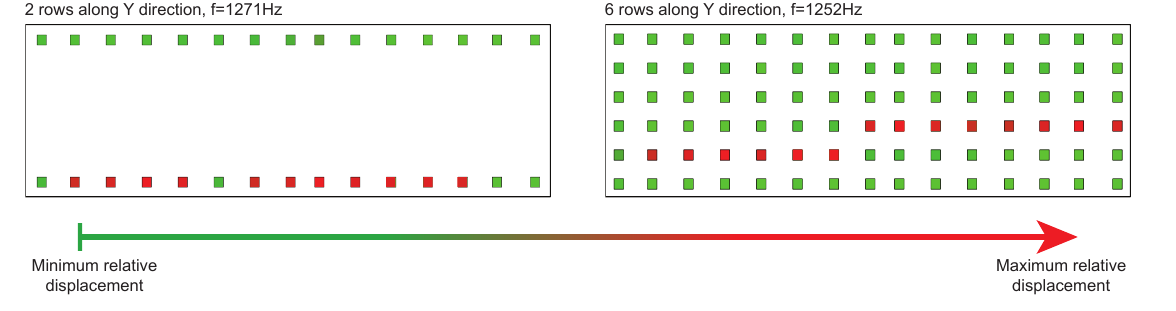
Figure 10. Blade-strip contact patch top view: relative displacements along X direction for two different combinations of condensation nodes: 15 node columns along X, and 2 or 6 rows along Y